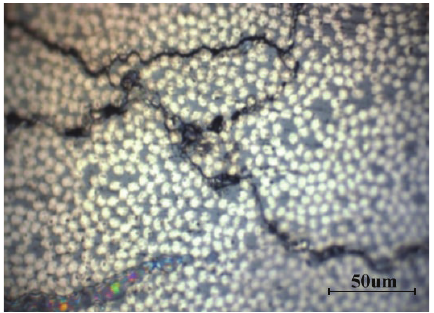
Figure 5: Micromorphology of matrix cracking in T700/6808 composite (AE amplitude ≥ 55 dB and ≤